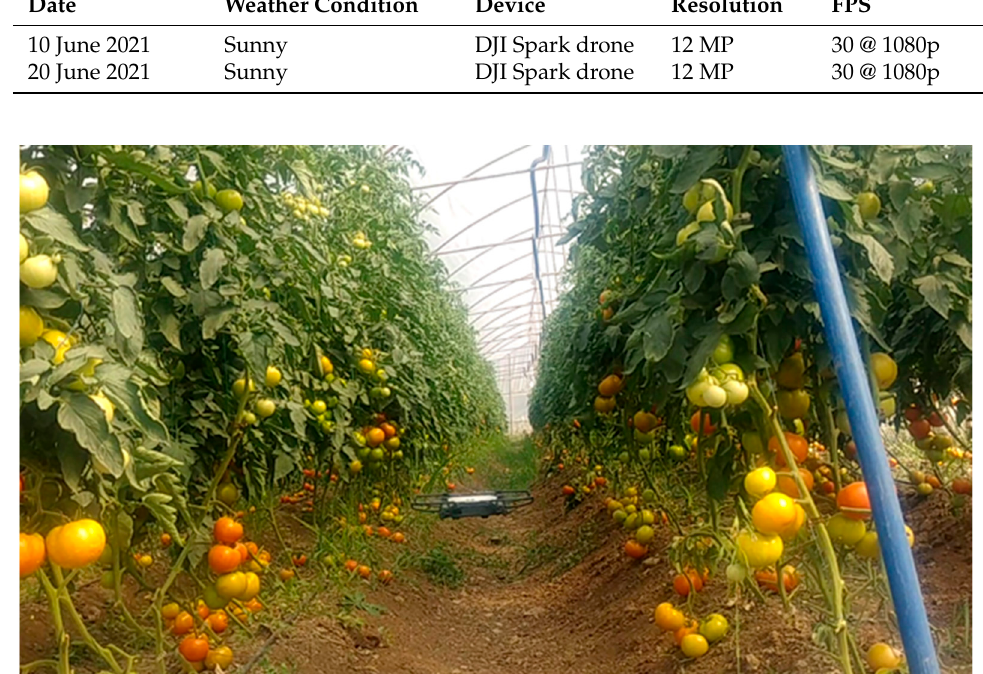
Figure 5. Drone Video Capturing.